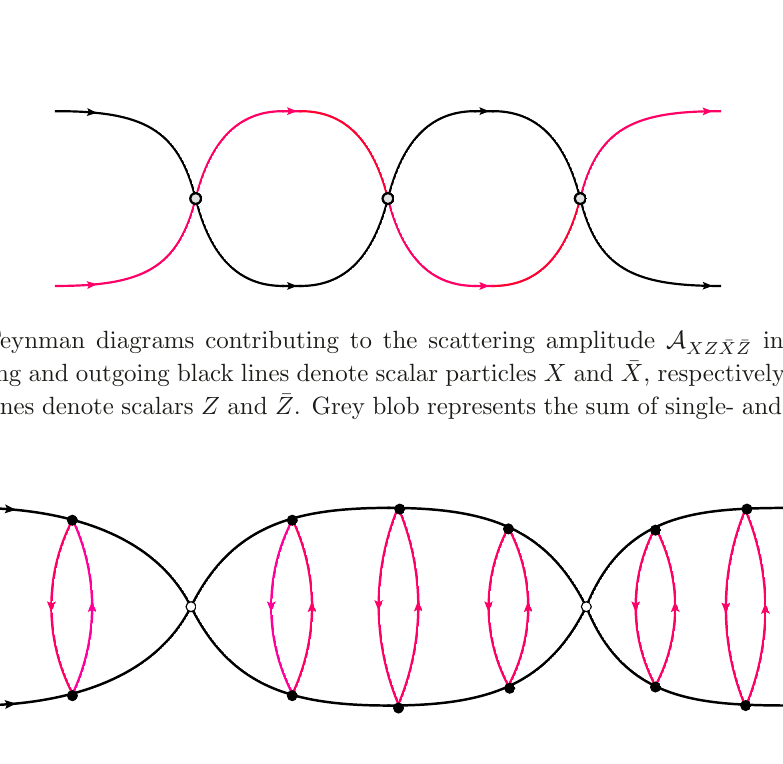
Figure 2 . Feynman diagrams contributing to the scattering amplitude blobs represent the single- and double-trace vertices,